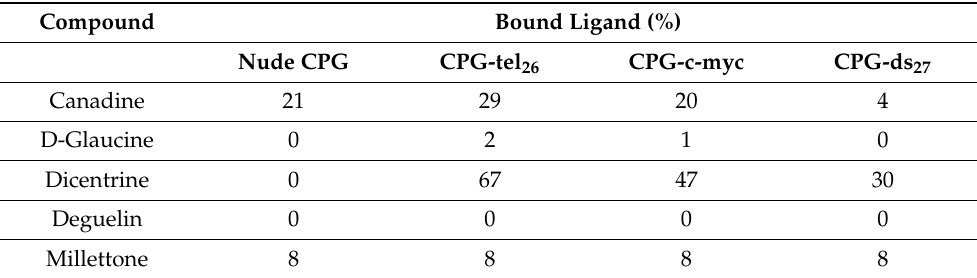
Table 2. Summary of the binding assay data obtained for the studied natural compounds using the G4-CPG assay. The bound ligand amounts are calculated as the difference between the initially loaded amount of ligand and the unbound ligand recovered by the washing solution and are expressed as a percentage of the quantity initially loaded on each support. The errors associated with the reported percentages are within ± 2%. Compound Bound Ligand (%) Nude CPG CPG-tel 26 CPG-c-myc CPG-ds 27